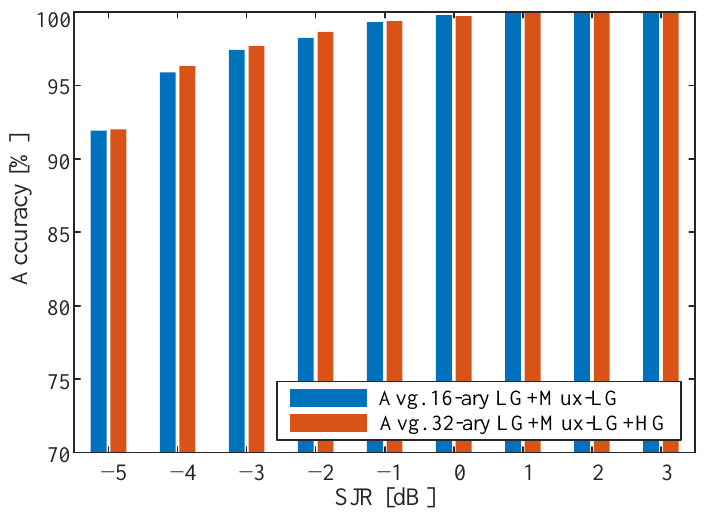
Figure 8. Average accuracy for 16-ary LG+Mux-LG and 32-ary LG+Mux-LG+HG modulation